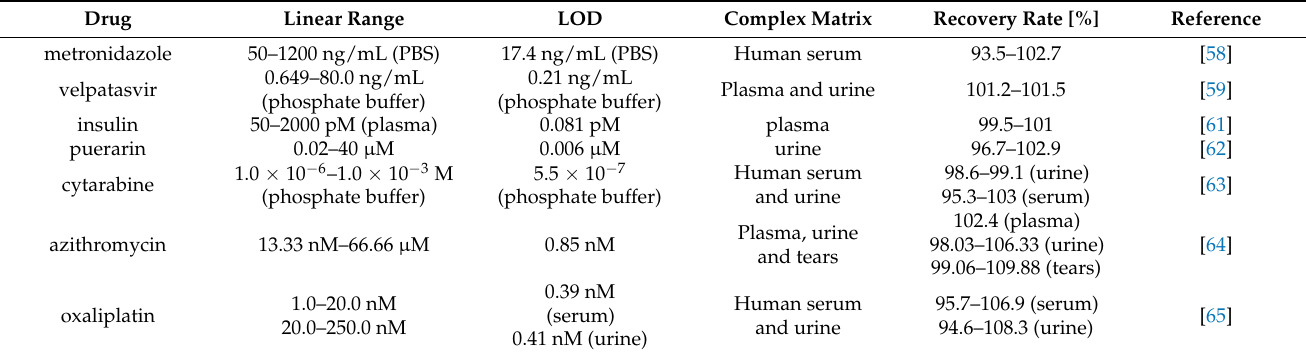
Table 2. A selection of target analytes for MIP-based sensors aiming at therapeutic drug monitoring.